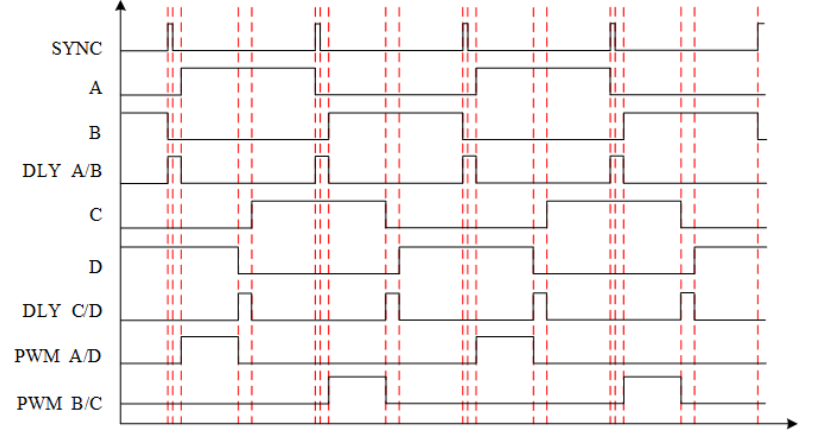
Figure 6. Waveform of the control signal of